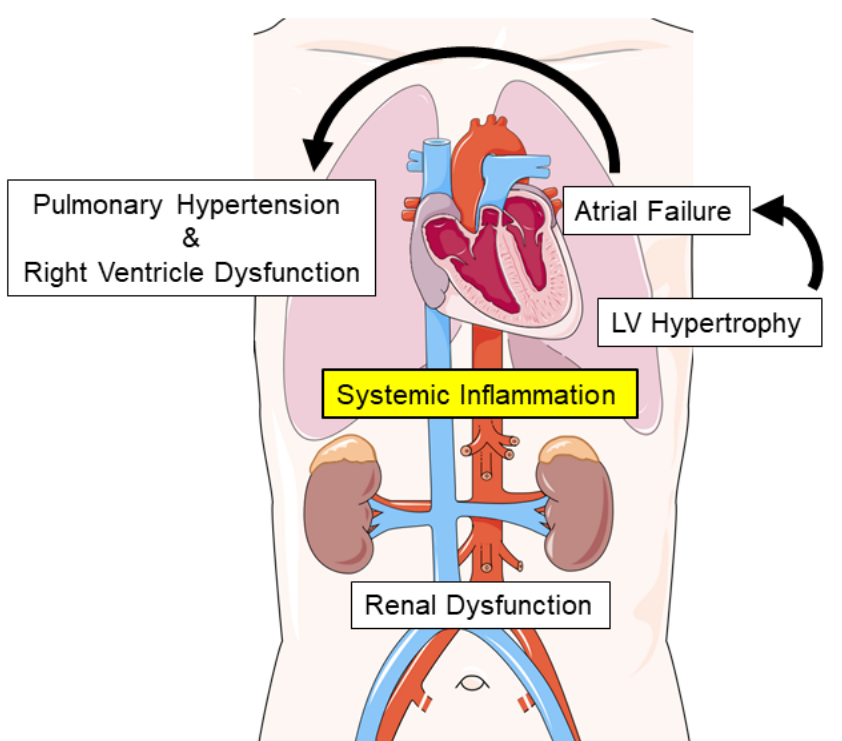
Figure 1. Mechanisms involved in transitioning from the pre-HFpEF stage to symptomatic HFpEF.